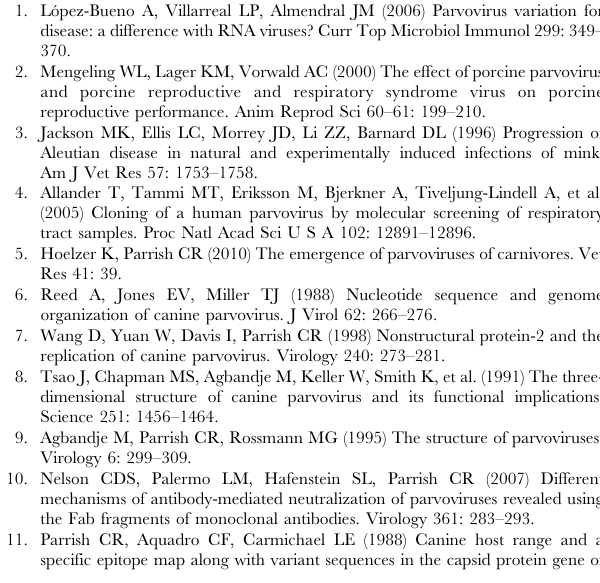
Figure S1 Amplicons and primers used in the molecular cloning and deep-sequencing analyses. Sequences of all primer used in this study are included below. The asterik indicates primers that were used for Sanger sequencing of the full-length genome. Dataset S1 Deep-sequencing profile in sample 370; the two PCR amplicons that together span the entire CPV coding sequence (4269 nt) include a CPV-2a and CPV-2c strains (distinguishing nucleotides between both strains are highlighted in yellow).